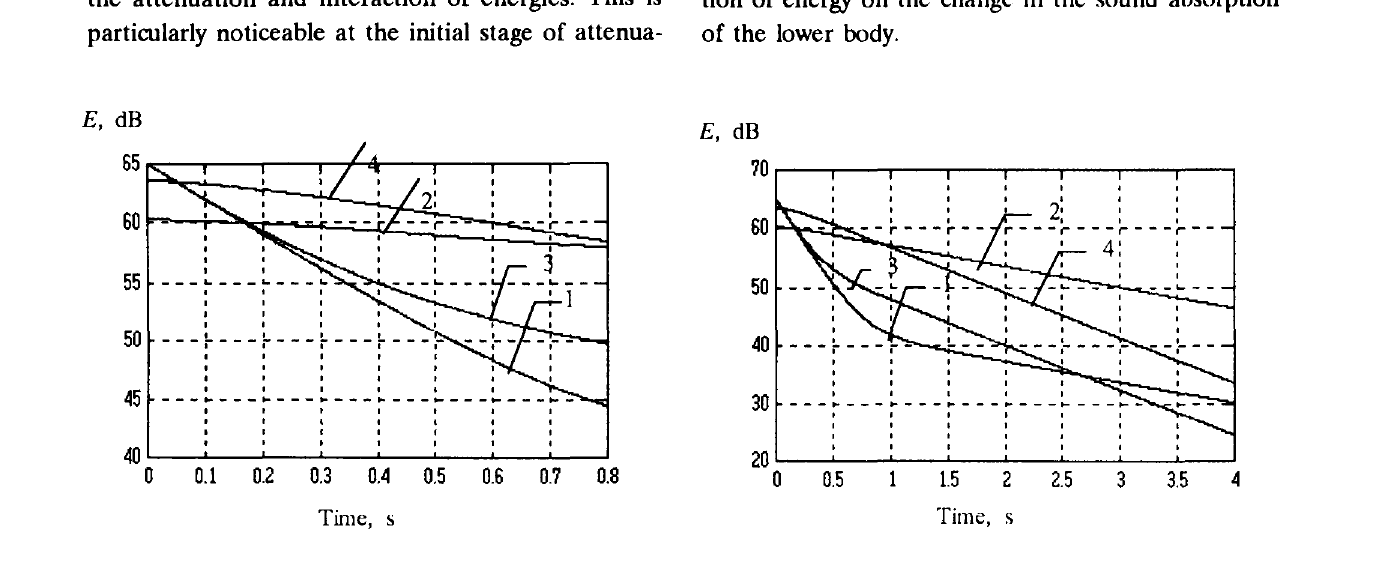
Fig 5. The dependence of the attenuation of the sound Fig 6. The dependence of the attenuation of the sound energy over 800 ms on the area of the opening. 1 and 2 energy over 4000 ms on the area of the opening. I and - volume of the lower body V and of the upper body V and of the upper body 2 - volume of the lower body V 1 2 1 when the area of the opening is 10 m 2; 3 and 4 - same V when the area of the opening is 10 m 2; 3 and 4 - 2 with the area of 50 m 2 same with the area of 50 m